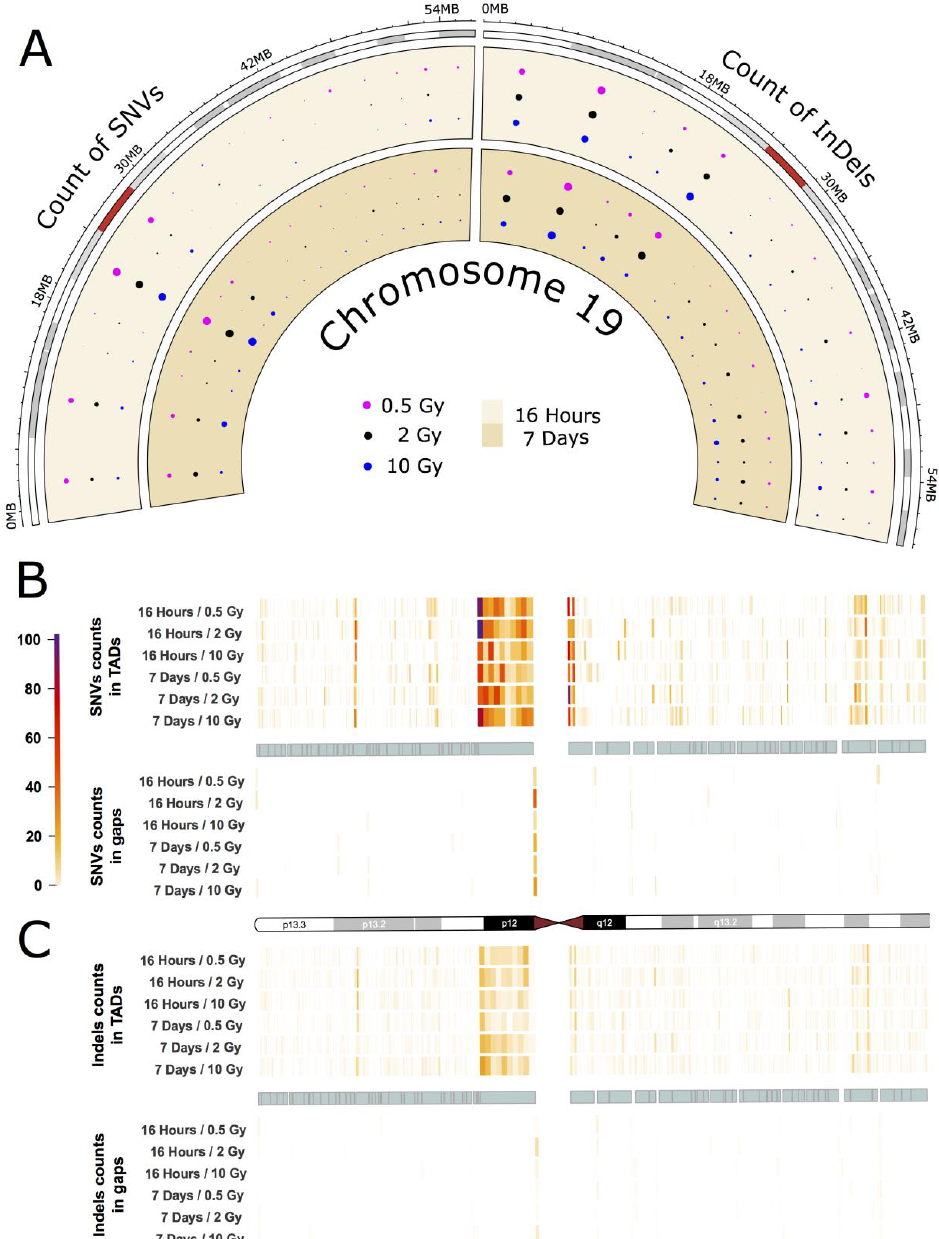
Figure 3. IR-induced variant accumulation across chromosome 19 (dataset 1). ( A ): Distribution of SNVs and InDels over cytogenetic bands. Topologically associating domain (TAD) plot showing the distribution of SNV ( B ) and InDel ( C ) counts inside and outside of TAD coordinates for chromosome 19. The chromosome is represented in the middle of the figure as an ideogram. Each panel is subdivided, showing the SNV and InDel alteration counts inside (above) and outside of TADs (below). The TADs are shown as cyan blocks symmetrically in both panels. Each TAD and each gap (region outside TAD termed as gap) was binned into 10 equally long portions and the counts of the SNVs or InDels were then calculated for each portion. The heatmaps with color gradients from white through orange and red to dark purple represent values ranging from 0 to 104 of variant